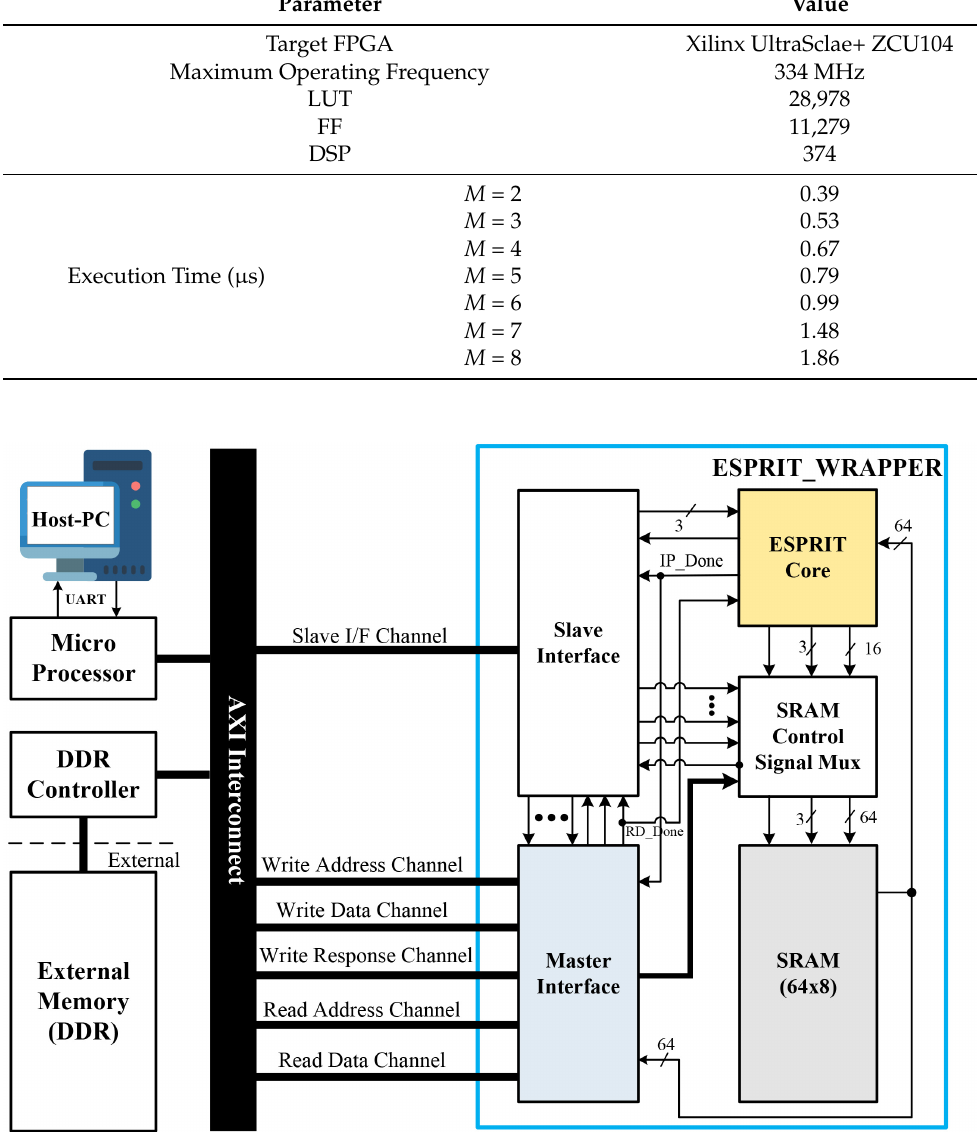
Figure 11. System architecture of the proposed ESPRIT